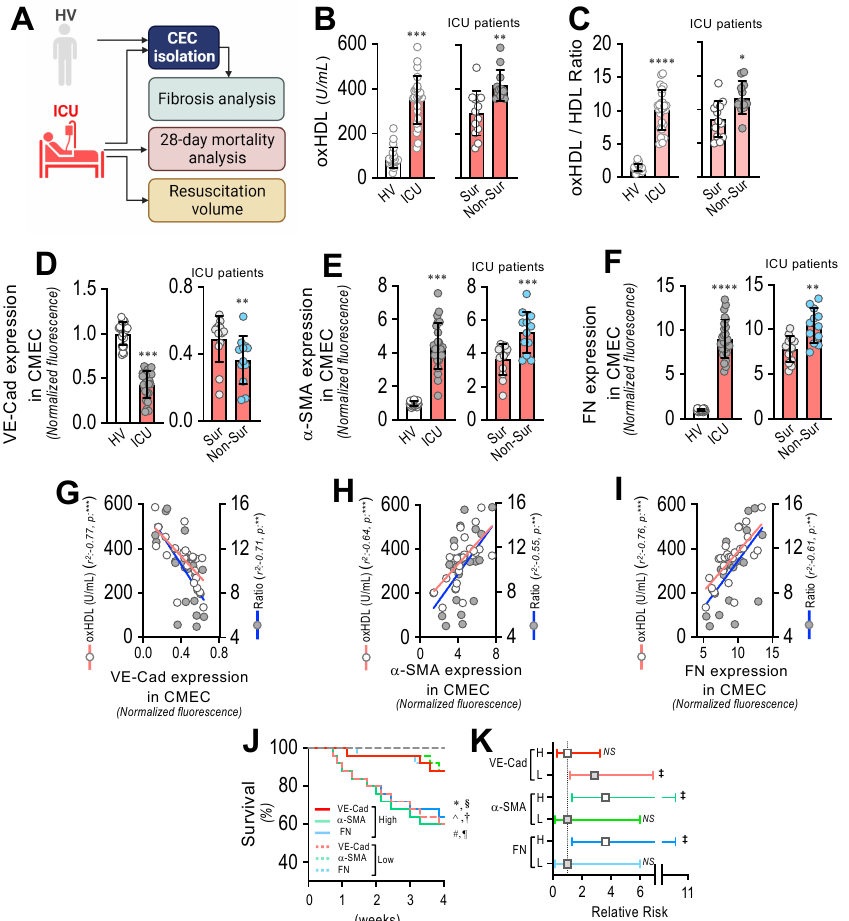
Figure 8. Circulating endothelial cells from ICU patients show a fibrotic expression pattern, which correlates with plasma oxHDL levels associated with decreased survival and increased risk of death. ( A ) Experimental strategy for ICU patients (N = 25) and HVs (N = 22). ( B , C ). Plasma oxHDL ( B ) and oxHDL/HDL ratio ( C ) determinations in healthy volunteers (HVs) and ICU patients (left panels) and in surviving and non-surviving ICU patients (right panels). ( D – F ). VE-cadherin ( D ), α -SMA ( E ), and FN ( F ) expression in CMECs extracted from healthy volunteers (HVs) and ICU patients (left panels) and in surviving and non-surviving ICU patients (right panels). ( G – I ) Correlation analyses between VE-cadherin ( G ), α -SMA ( H ), and FN ( I ) expression in CMECs extracted from ICU patients